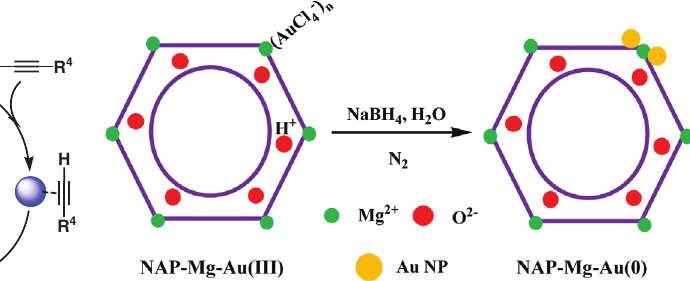
Scheme 14 Preparation of NAP-Mg-Au(0) catalyst. Redrawn from [67].